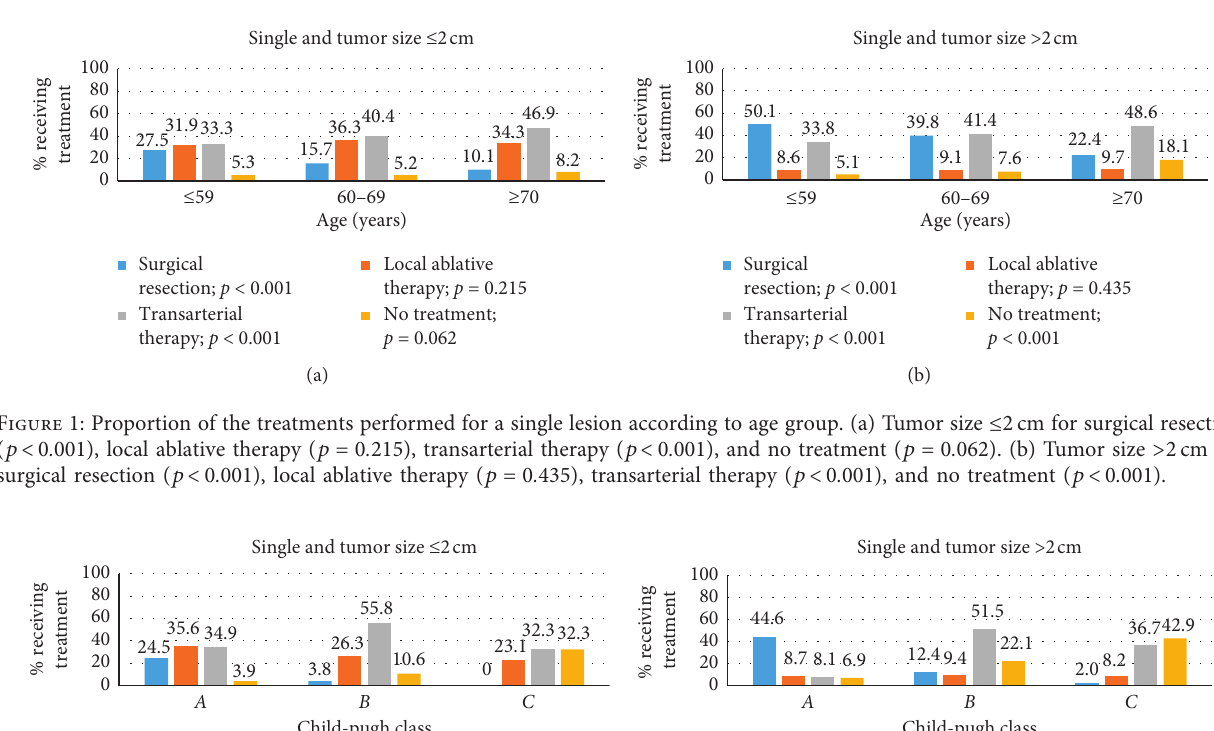
Surgical resection; p < 0.001